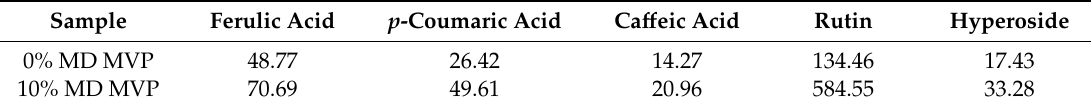
Table 7. Polyphenol content ( µ g / mL extract) in MVPs obtained using HPLC-DAD.